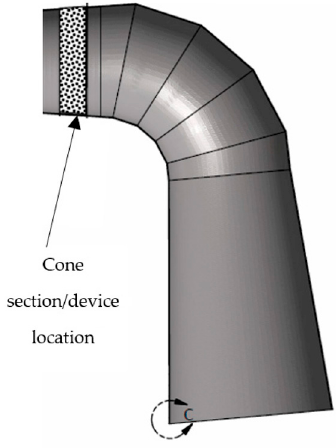
Figure 3. Recommended area for aeration device location.